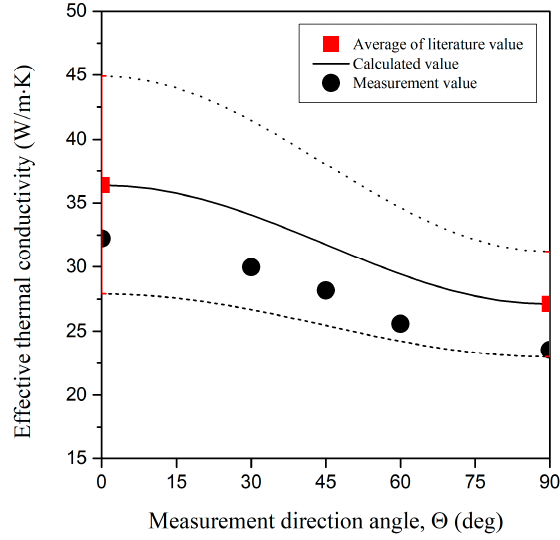
Figure 11. Experimental results for various measurement directions.